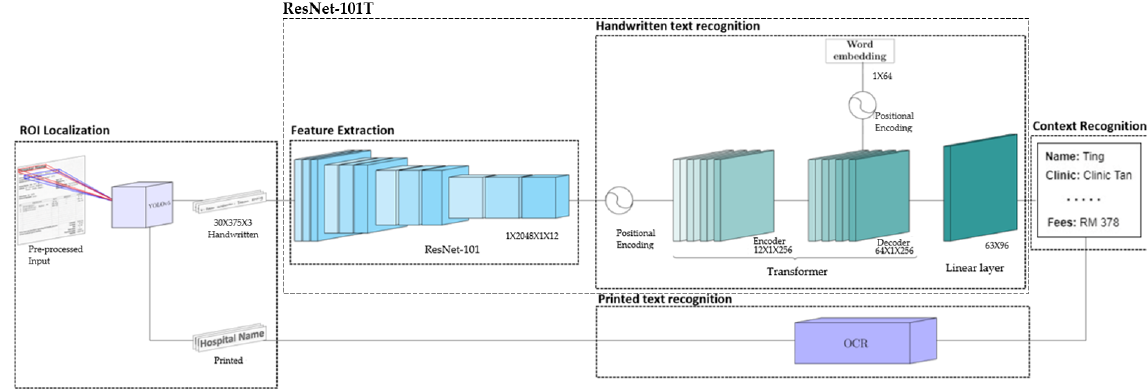
Figure 2. HTR pipeline process and architecture.